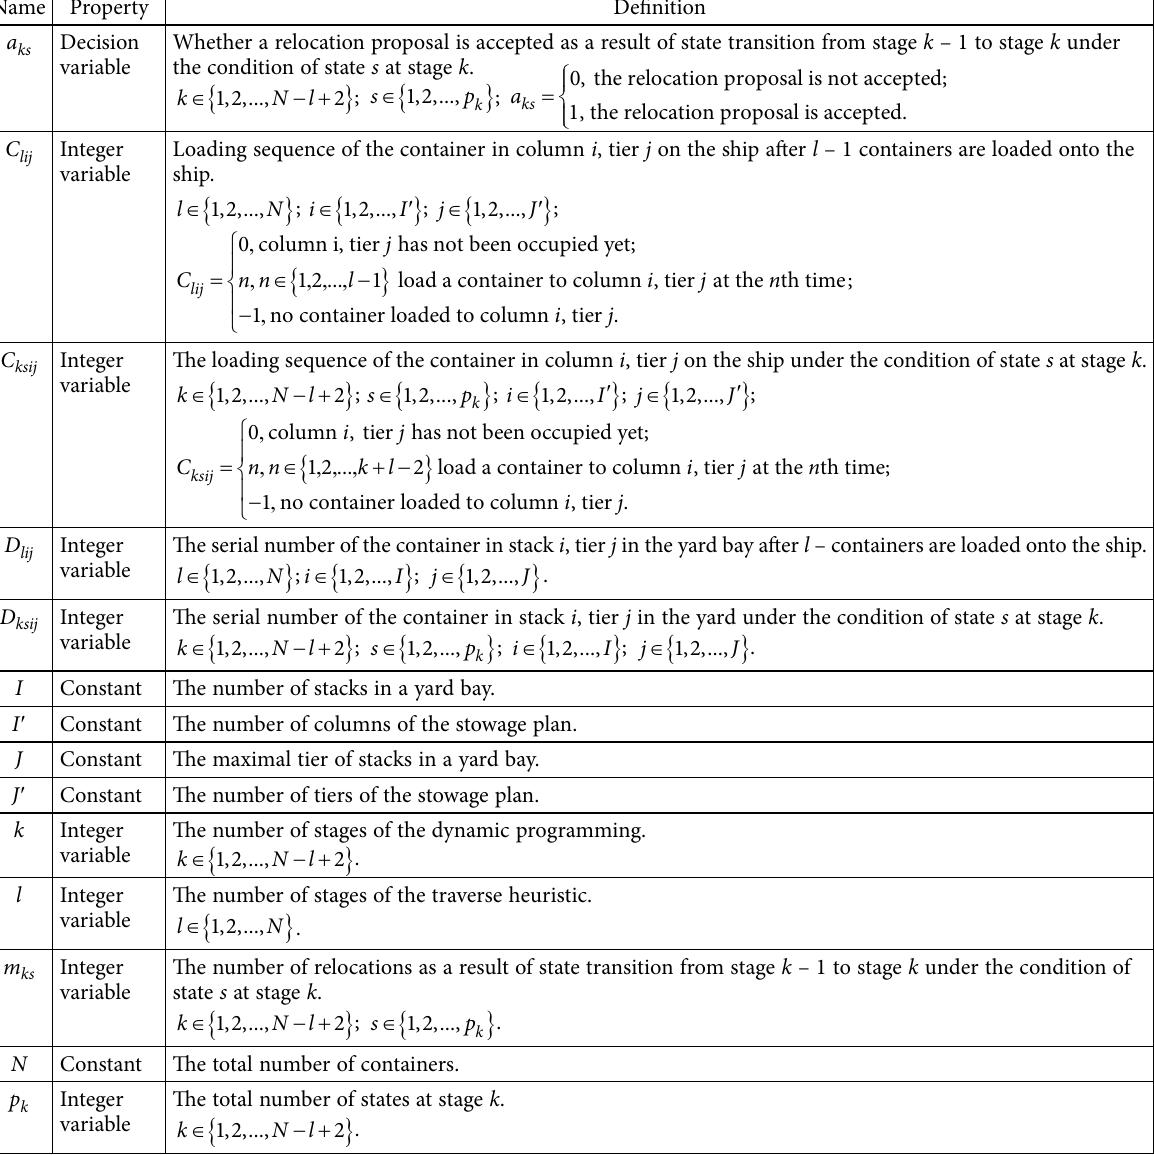
– – – Step 2: From the left to the right, compare the top non-zero figure in stack i of D of C , which corresponds with the bottom zero figure of C . Then turn to Step 3. l –